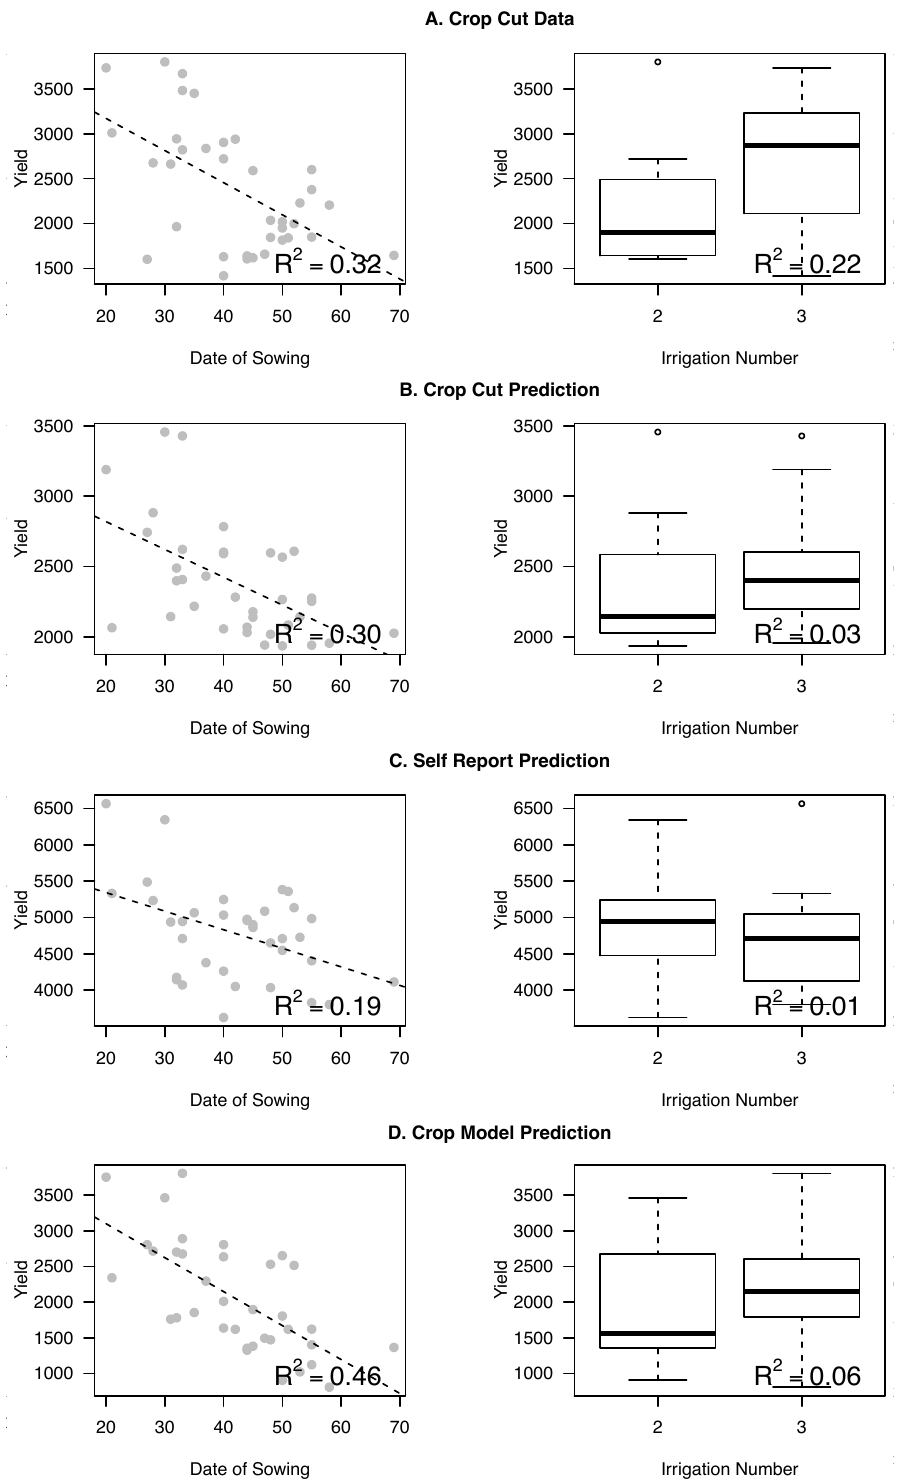
Figure 7. The relationship between yields, sow date, and urea fertilizer added for 2015–2016 data: ( A ) known relationships between these management variables and yield as measured using the crop cut yield data collected in the field; ( B ) relationships with yield estimates using the crop cut parameterized model; ( C ) relationships with yield estimates using the self-report model; and ( D ) relationships with yield estimates using the crop model parameterized model. R 2 between management variables and yield are highlighted in each